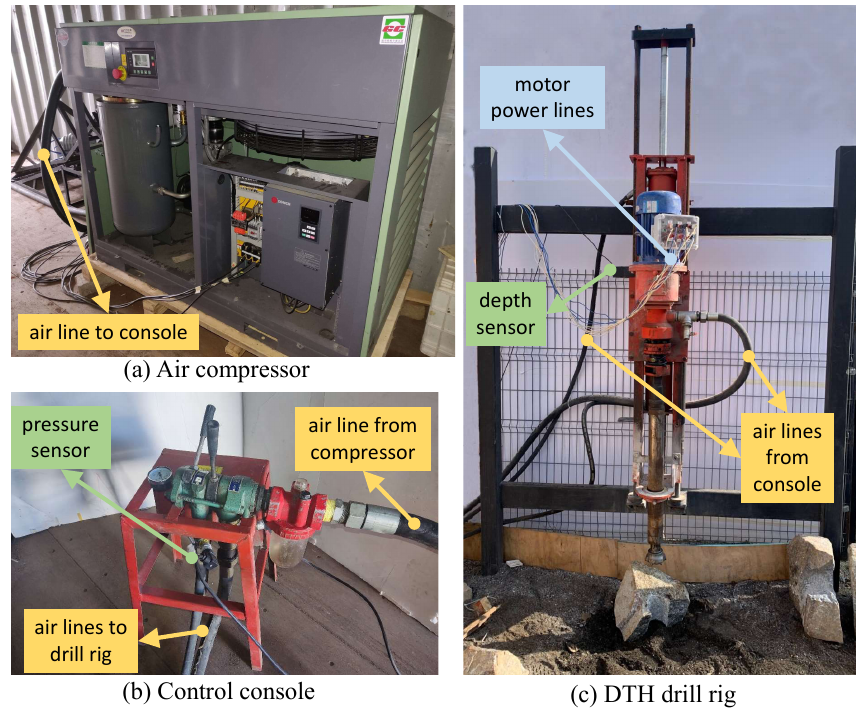
Figure 1. DTH drilling setup including main components and their